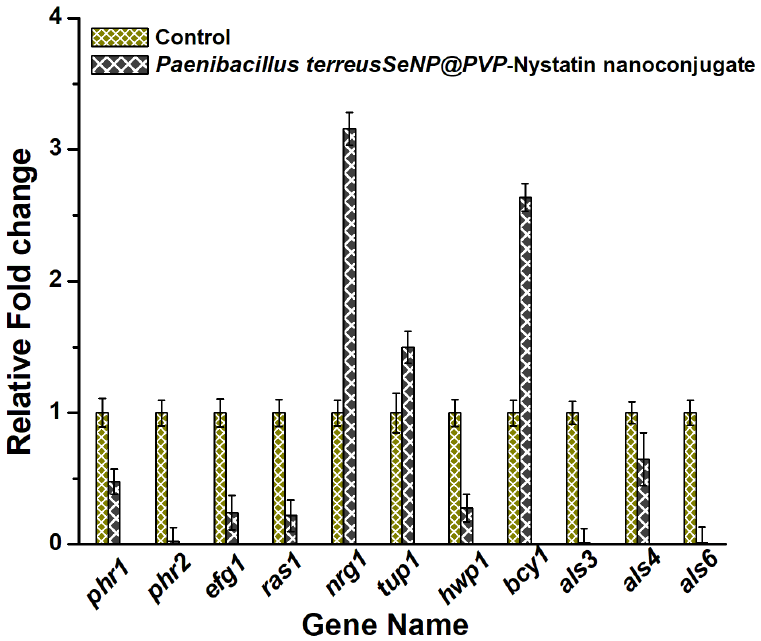
Figure 7. The anti-morphogenesis mechanism of SeNP@PVP_Nystatin nanoconjugates. The real-time polymerase chain reaction (RT-PCR) of the genes (phr1, phr2, efg11, ras11, tup1, hwp1, als3, als4,